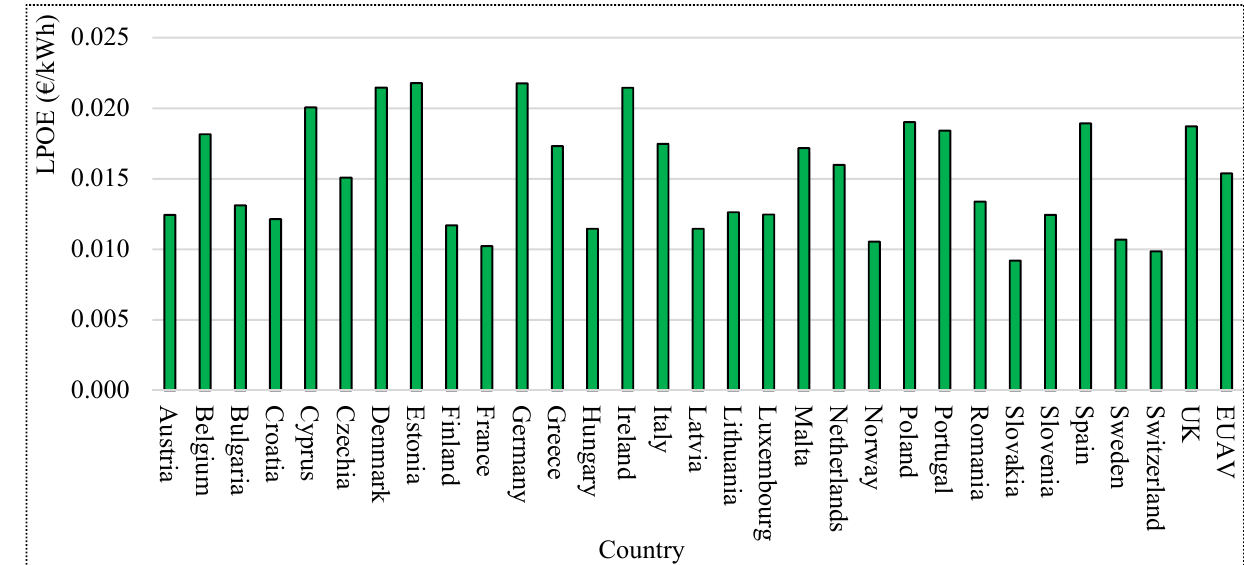
Figure 6. Levelised profit of environmental benefits (LPOE) of the BIPV system. When it comes to NPV E in the EU, Norway with a net present value of 30 € per sq.m. has the lowest amount, which is basically because of its low GHG emission in power production (thanks to hydropower production potential) and a quite low lost rate in the power transmission lines. The highest amount belongs to Cyprus because of its relatively high electricity price and GHG emission of its power